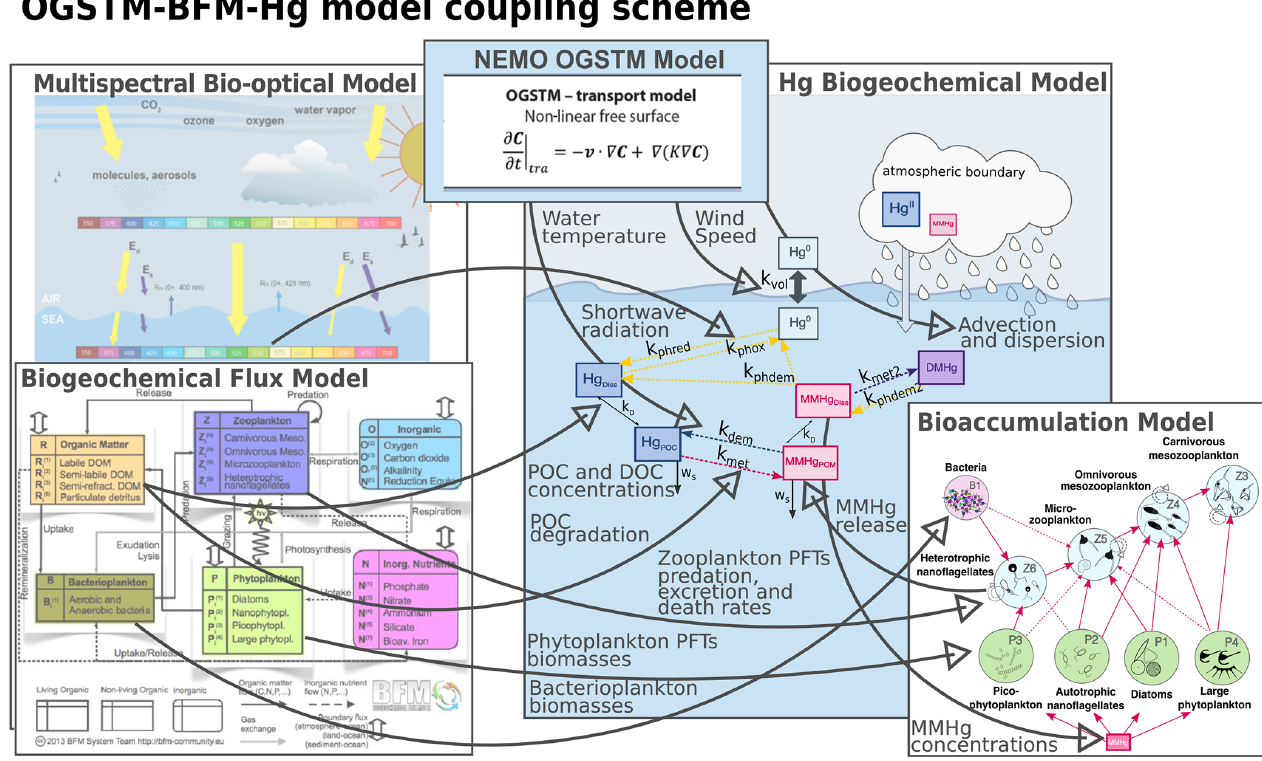
Figure 2. Overview of the coupling in the OGSTM–BFM–Hg model, which integrates the biogeochemistry and bioaccumulation of Hg species in the OGSTM–BFM model, previously coupled to the transport model NEMO and to a multispectral biotical model. The thick grey arrows with text highlight variables and fluxes read by the Hg biogeochemical model (Fig.